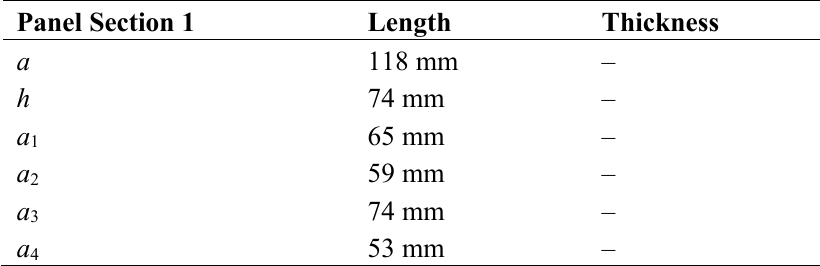
Figure 10; Panel 4 optimized for load conditions of Panel 1 (thickness of upper plate) and load conditions of Panel 3 (hat stiffener of Panel 3), see Table 8, Table 9, Figure 11. Table 2. Dimensions of optimized Panel Section 1 (see Figure 2 for an explanation). Panel Section